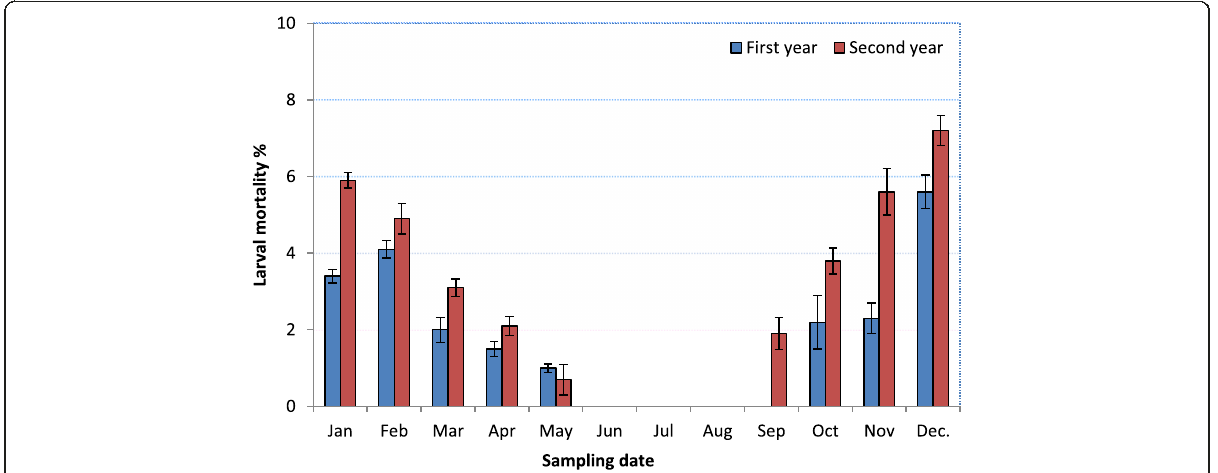
Fig. 1 Seasonal prevalence of Beauveria bassiana on Zeuzera pyrina larvae in pome orchards, throughout two seasons (2015-2016 & 2016-2017)